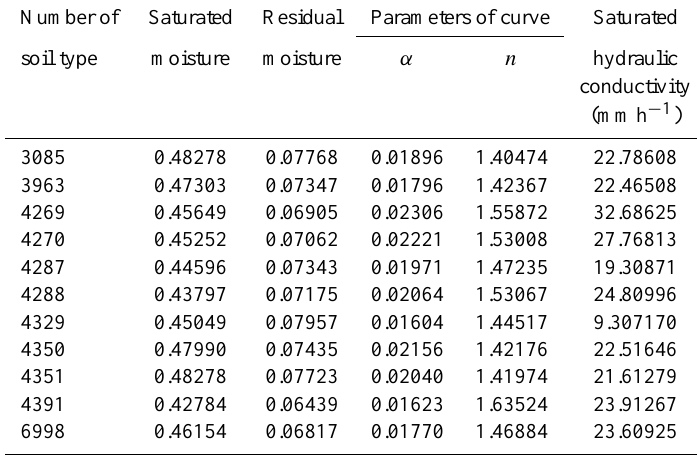
Table 4. The soil depth information in earthquake-affected area. Depth/ Percentage Depth of each soil layer/m m